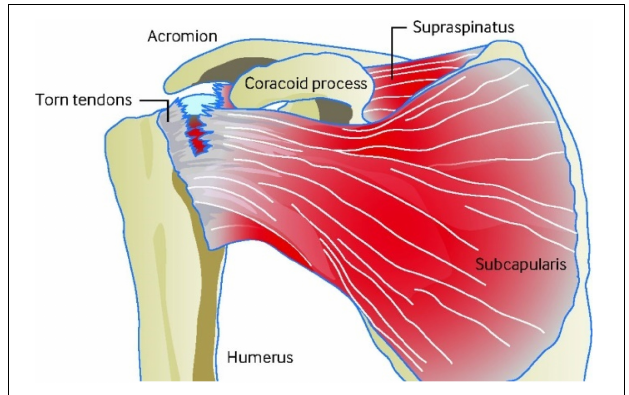
FIGURE 3 | Diagram of rotator cuff injury (Craig et al.,